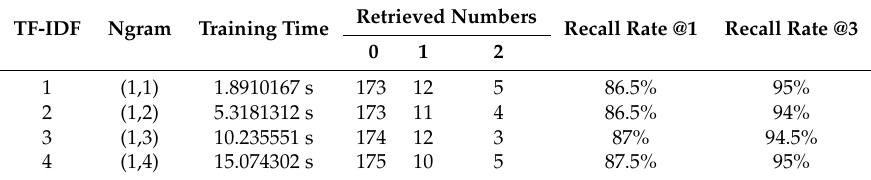
Table 1. Comparison of TF-IDF